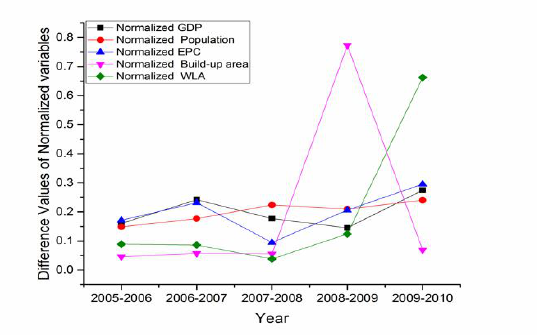
Figure 6 . The difference in values of the normalized